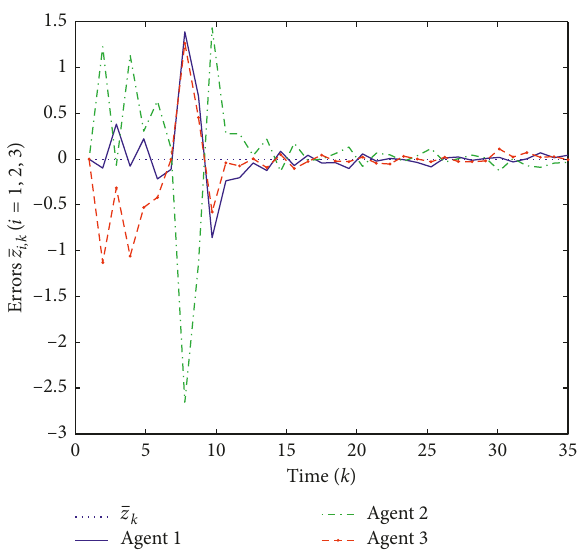
Figure 5: Output consensus error z